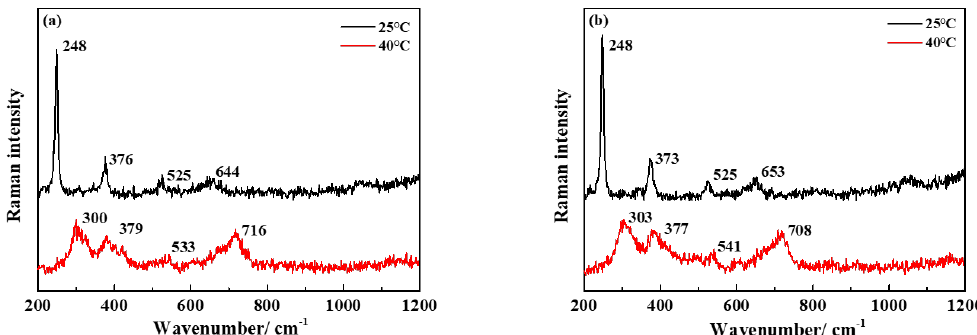
Figure 10. Raman spectra obtained on iron surfaces after 4 weeks immersion in the SG ( a ) and SG + 20 mM CaCl 2 ( b ) solutions.